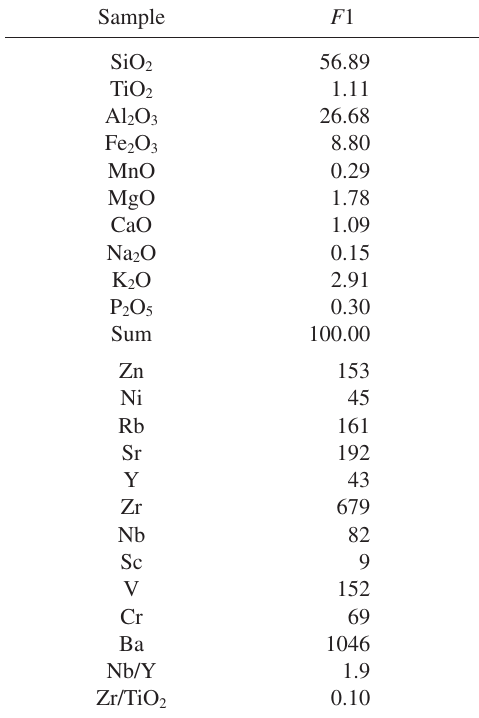
Table I. Major oxide (wt%) and trace element (ppm) contents for sample F 1, representative of tephra q . Water-free